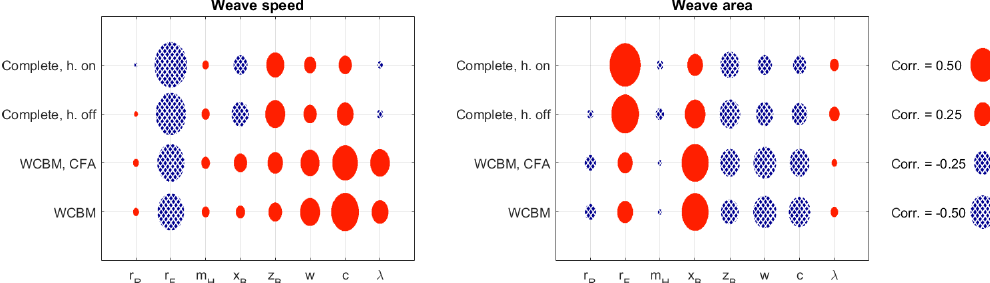
Figure 11. Correlation coefficients for the indices of the weave mode. Models of increasing complexity from bottom to top. Speed range: 0 to 10ms − 1